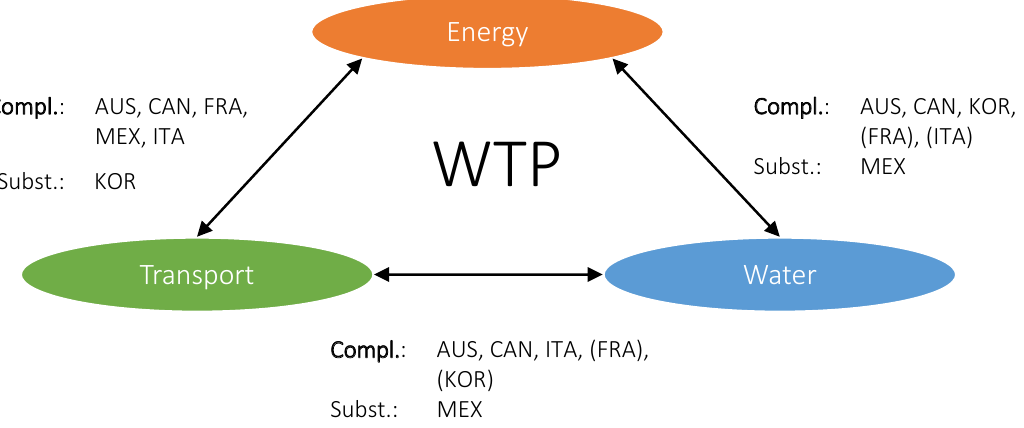
Transport Water